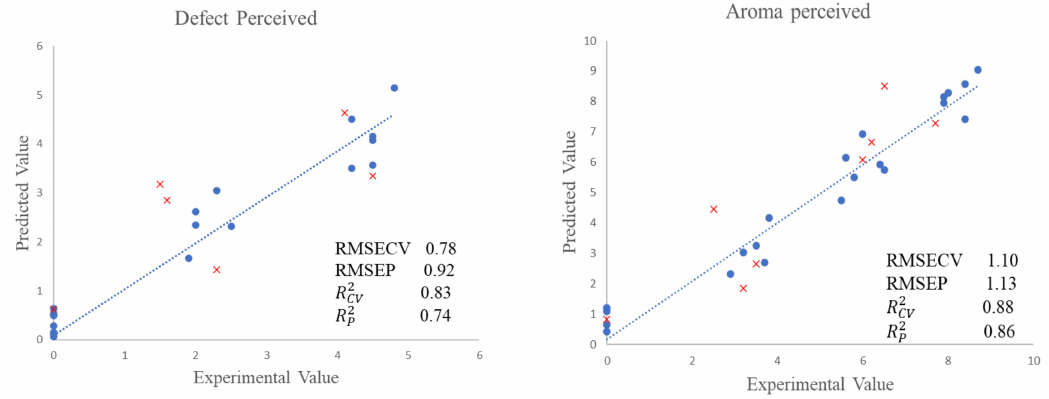
Figure 2. Experimental values against PLS cross-validation predictions ( • ) and validation set predic- tions (x) for defect and aroma